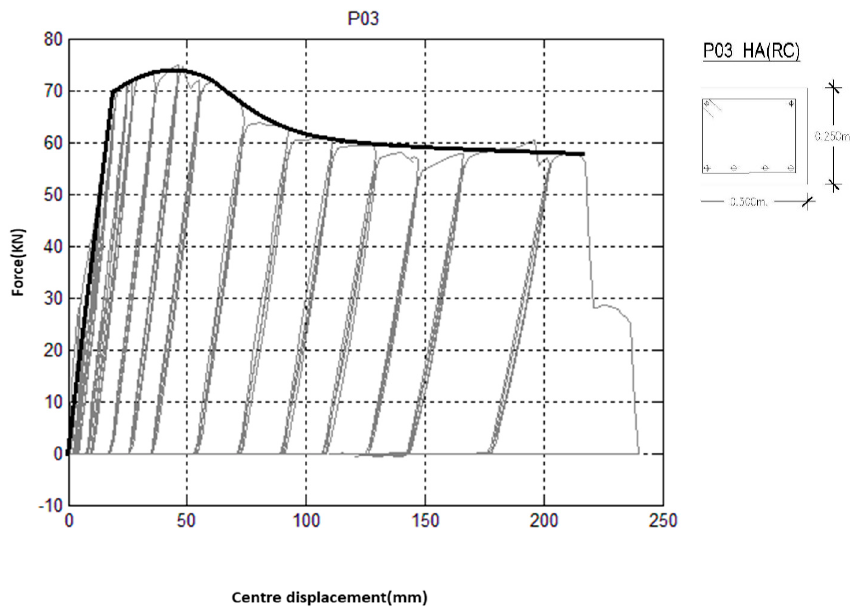
Figure 17. Force–displacement diagram of beam P03 from the experimental results.